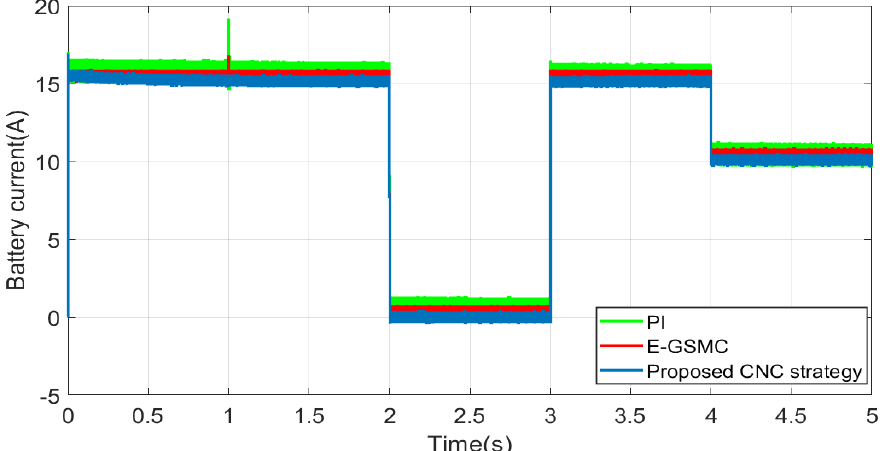
Figure 7. The robust tracking curve of the battery current.